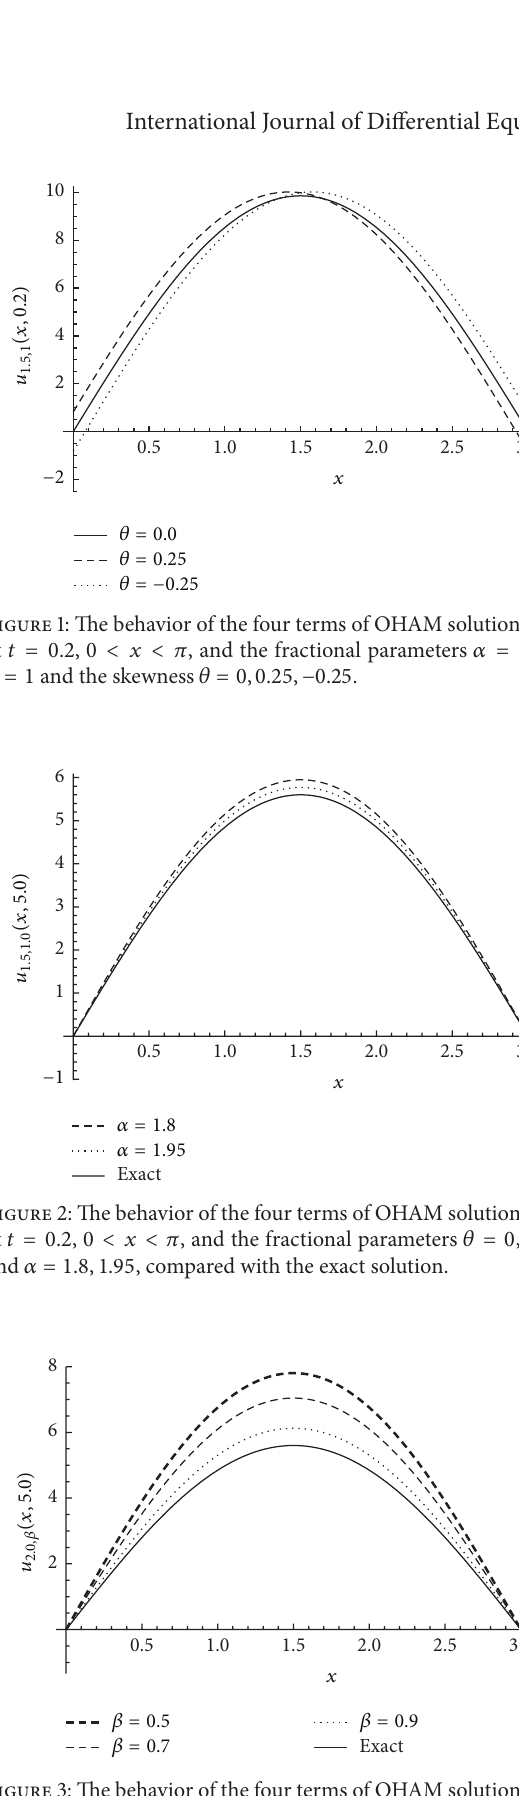
Figure 3: The behavior of the four terms of OHAM solution of (49) at 𝑡 = 0.2 , 0 < 𝑥 < 𝜋 , and the fractional parameters 𝜃 = 0 , 𝛼 = 2.0 , and 𝛽 = 0.5, 0.7, 0.9 , compared with the exact